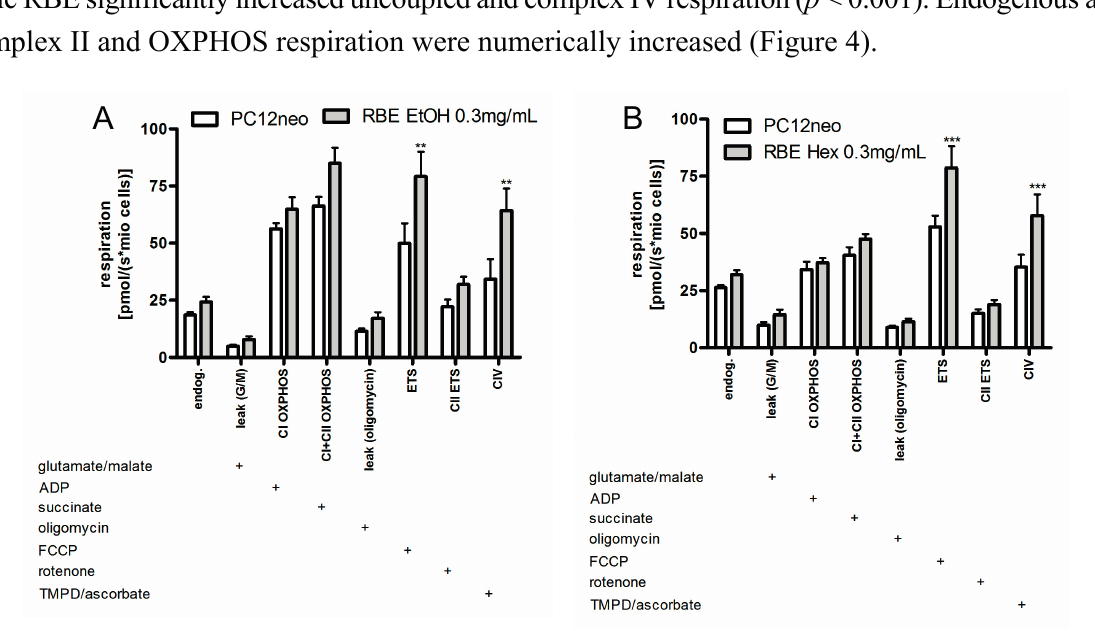
Figure 4. Cell-count normalized respiration of PC12 cells after a 24-h incubation with 0.3 mg/mL ethanolic (RBE EtOH, ( A )) or hexanic (RBE Hex; ( B )) rice bran extract